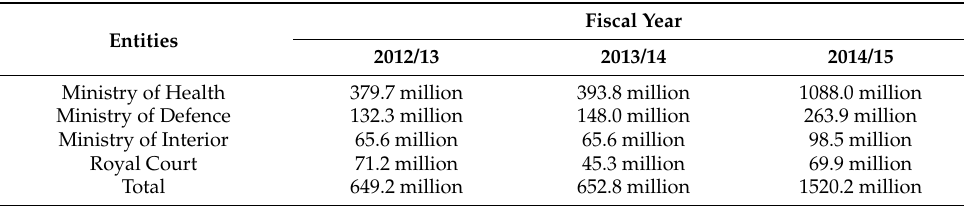
Table 1. Government spending on sending patients abroad for treatment in USD for the fiscal years 2012/13, 2013/14, and 2014/15 (Ministry of Finance,